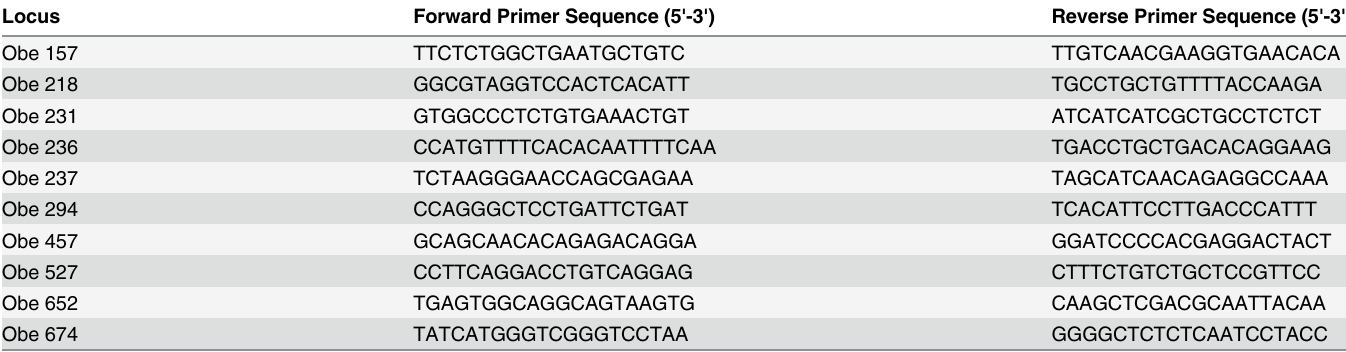
Table 1. Forward and reverse 5'-3' primer sequences used in PCR amplification of ten DNA microsatellite markers [15].